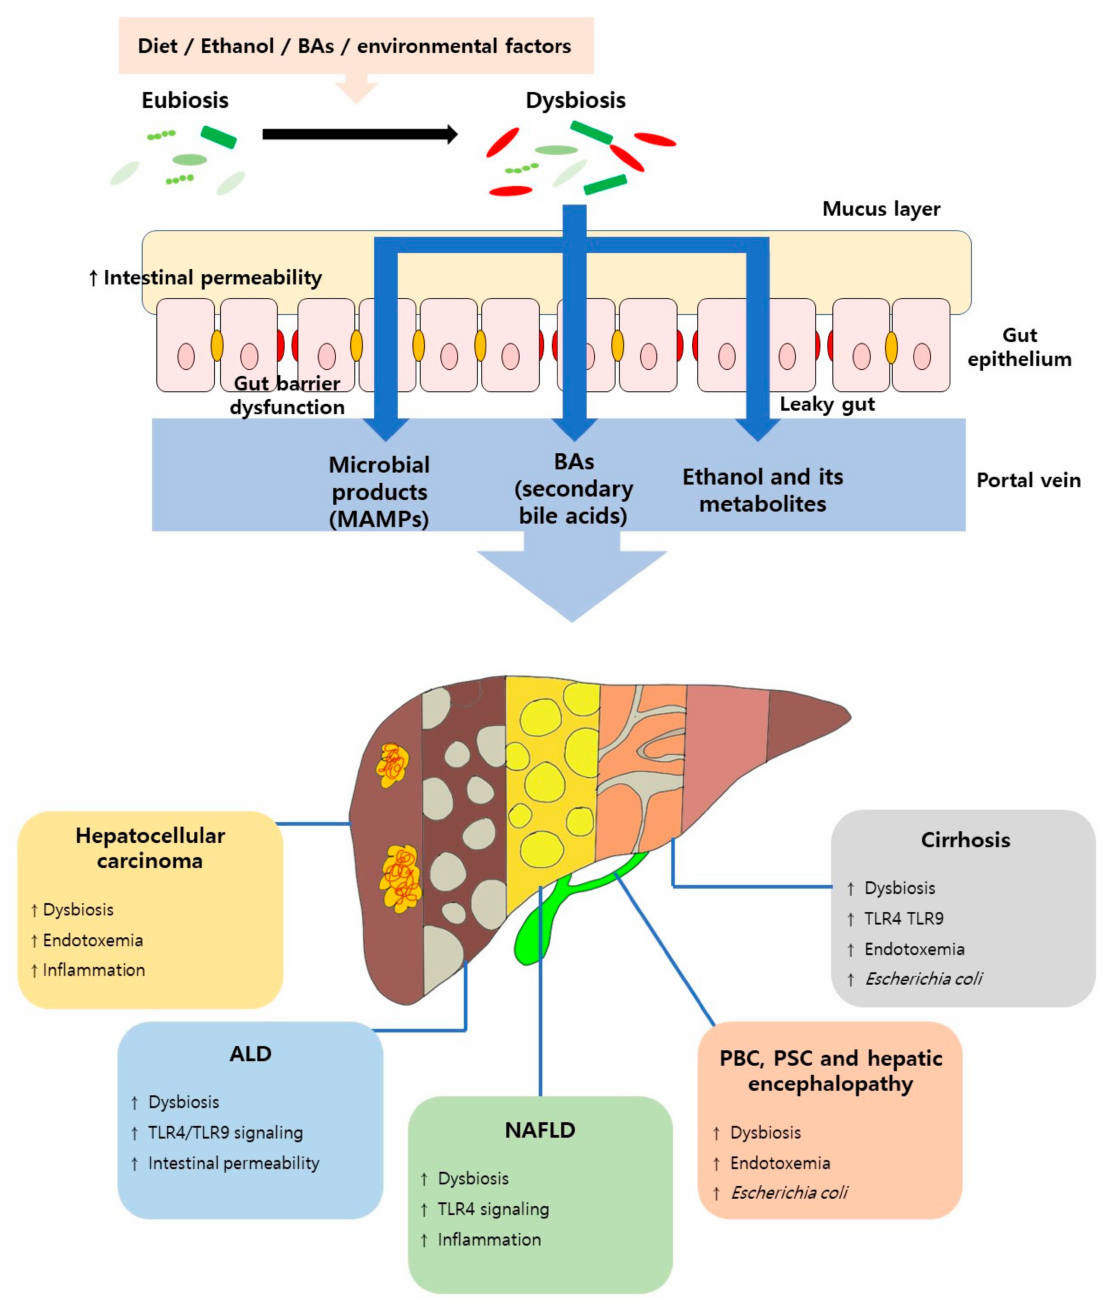
Figure 1. The role of the gut microbiota in liver disease. ALD, alcoholic liver disease; BAs, Bile acids; MAMP, Microbial- associated molecular patterns; NAFLD, nonalcoholic fatty liver disease; PBC, primary biliary cholangitis; and PSC, primary sclerosing